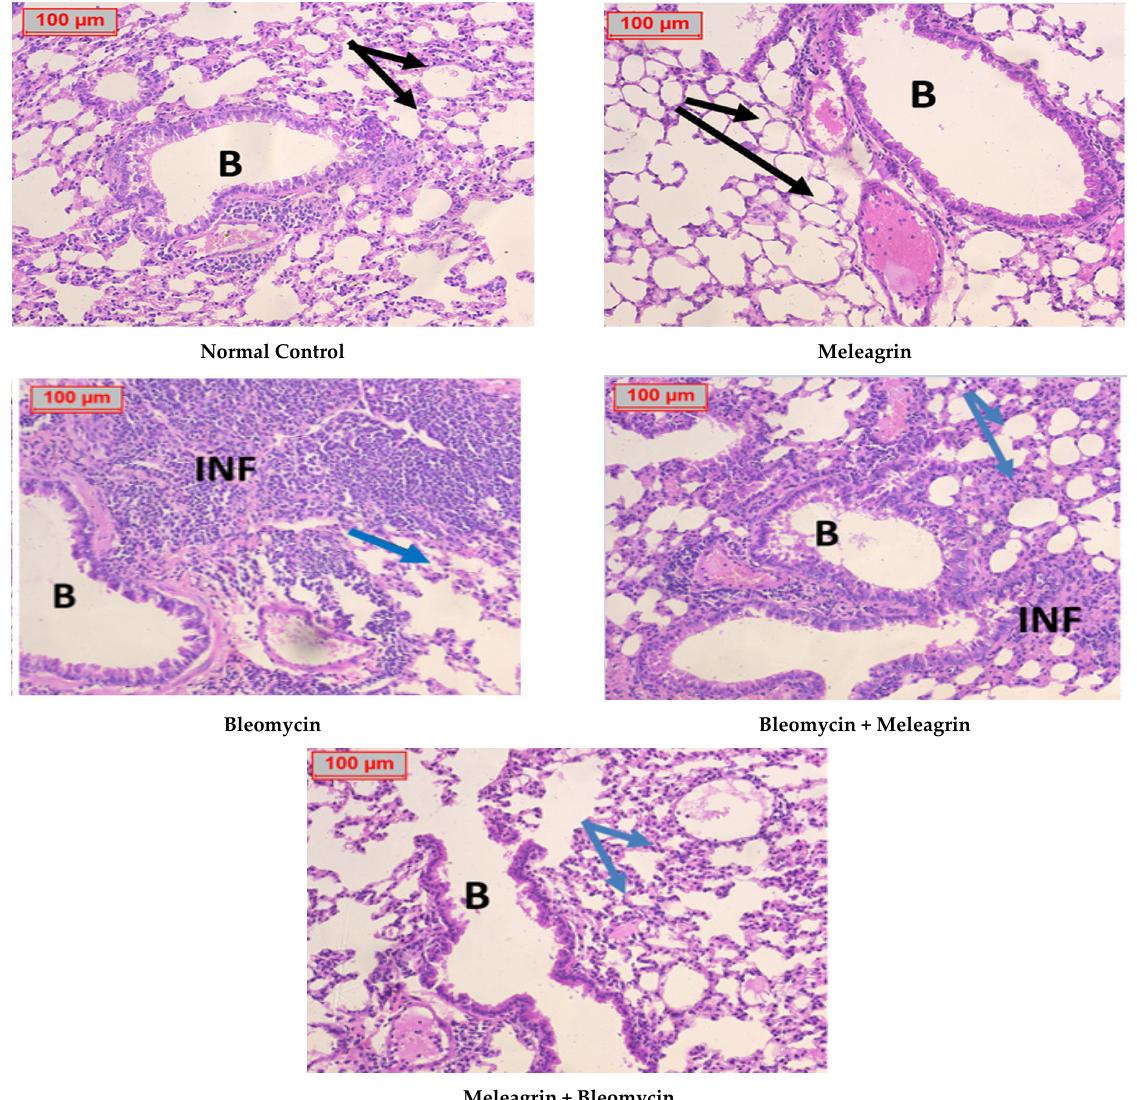
Figure 13. A photomicrography of lung tissue (H&E, ×200). Normal control group and meleagrin group: showing normal bronchial tissue as the bronchia have an intact wall and the alveolar walls are also intact with normal thickness (black arrows). Bleomycin group: showing destructive bronchial tissue mostly infiltrated by massive areas of inflammatory cells with areas of mucin and thickened alveolar walls (blue arrows). Bleomycin + Meleagrin group: showing mild improvement with less destructive bronchial tissue infiltrated by focal areas of inflammatory cells, and slightly thickened alveolar walls (blue arrows). Meleagrin + Bleomycin group: showing great improvement with no detectable inflammatory cells and almost intact bronchial tissue with minimally thickened alveolar walls. B = bronchia, INF = inflammatory cells.